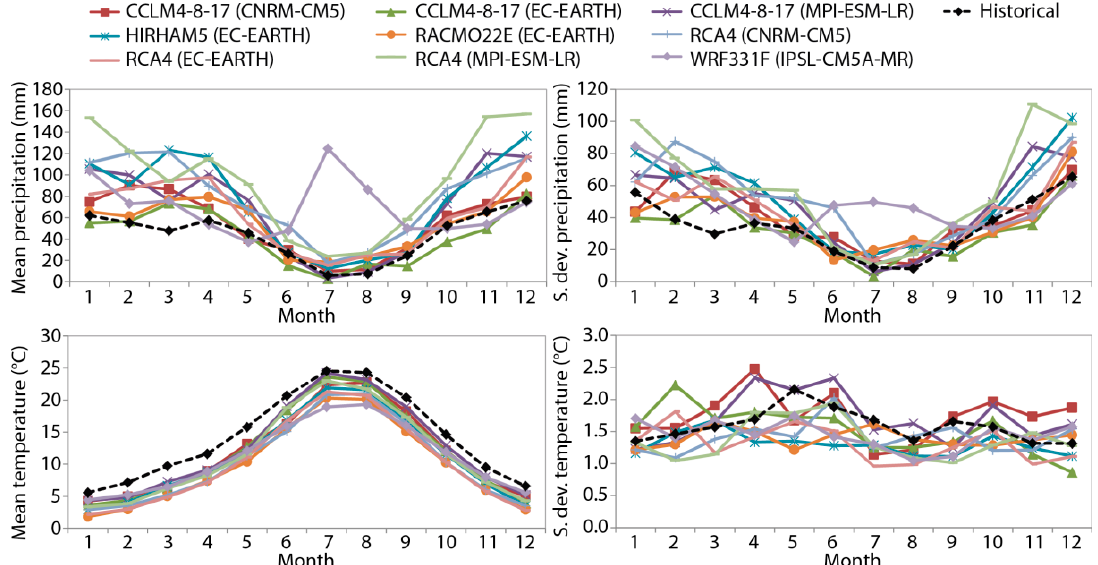
Figure 4. Monthly mean and standard deviation for the historical and control series (precipitation and temperature) for the mean year in the period 1971–2000—lumped approaches.